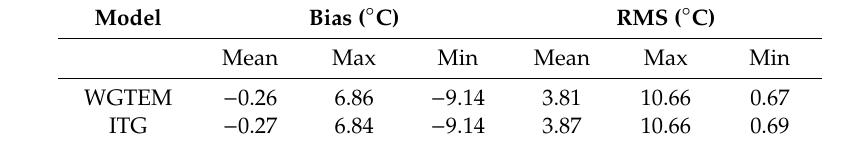
Table 3. Bias and RMS of temperature statistics from WGTEM and ITG models validated by NOAA data.